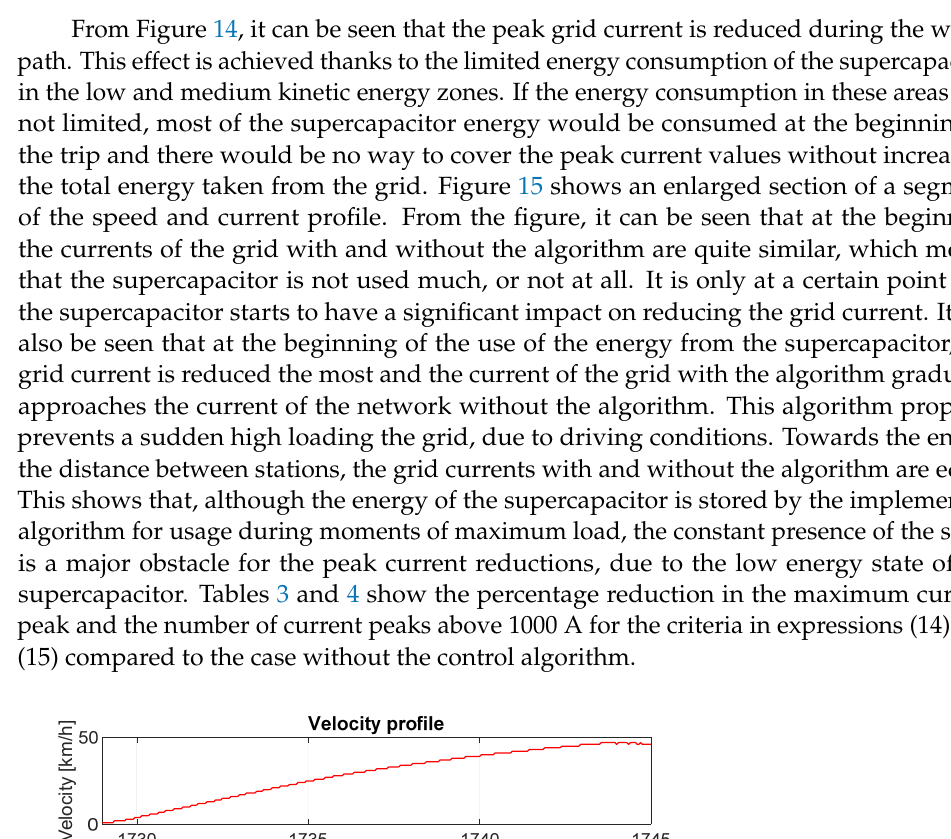
Figure 14. Comparison of grid current values with and without the use of the algorithm with the minimum energy criterion.